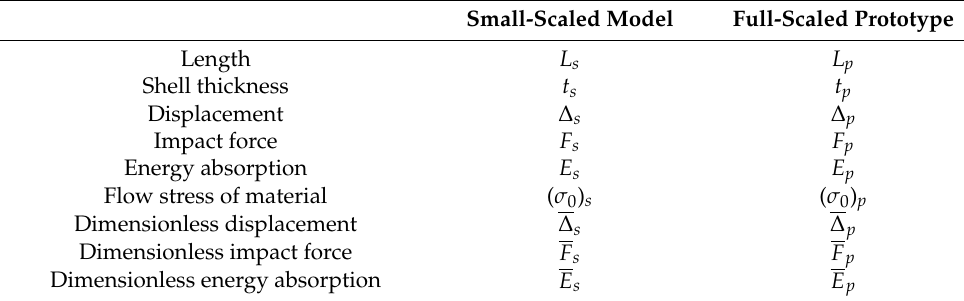
Table 1. Meaning of the symbols of small-scaled model and full-scaled prototype. Small-Scaled